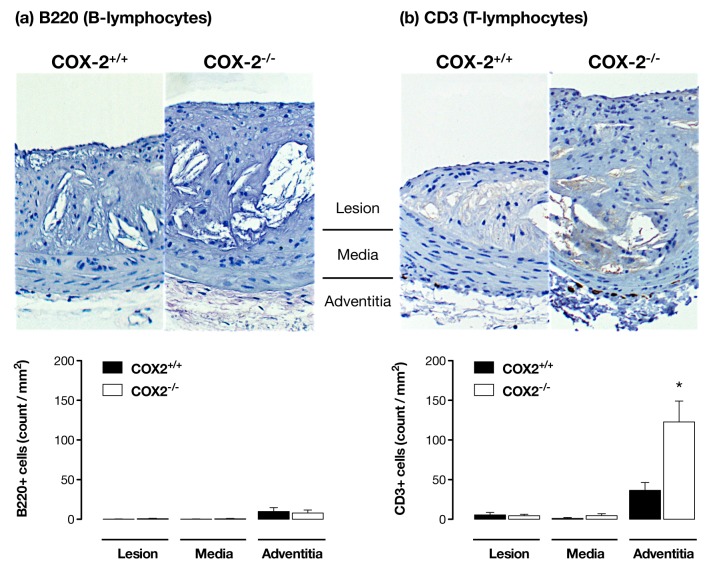
COX-2 deletion enhances T-lymphocyte infiltration into the adventitia of atherosclerotic vessels.Atherosclerotic lesions in the brachiocephalic artery of fat-fed apoE−/−/COX-2+/+ and apoE−/−/COX-2−/− mice were examined for B- and T-lymphocytes respectively by immunohistochemistry for B220 (a) and CD3 (b). B220+ cells were rarely observed in vessels of either genotype. By contrast, CD3+ cells were present as focal accumulations in the adventitial layer of apoE−/− mice, and the number and density of CD3+ cells present here was increased by deletion of COX-2. *; p<0.05 vs apoE−/−/COX-2+/+ by unpaired t-test; n = 5–10.